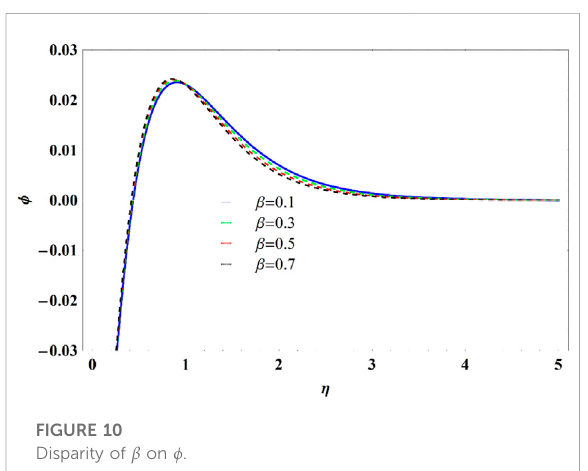
FIGURE 10 Disparity of β on ϕ .